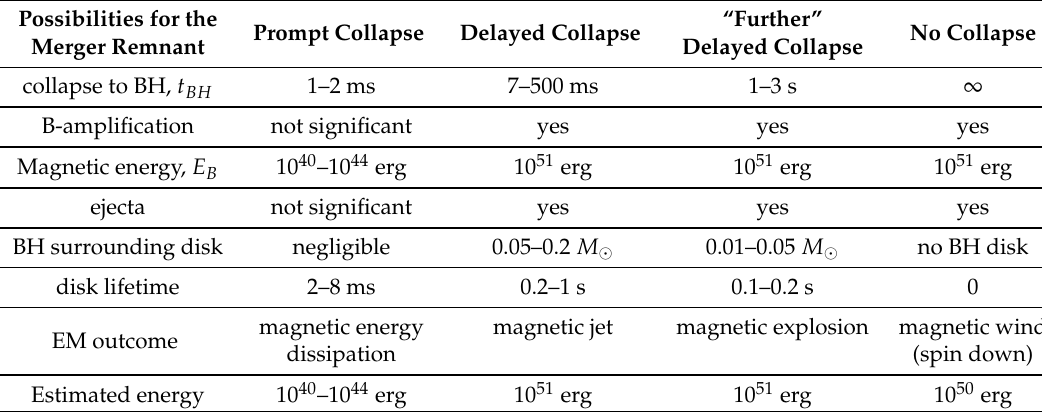
Figure 7. Snapshots of the density and poloidal velocity field for a model from [108]. The velocity vectors and their length correspond to the logarithm of the velocity in the poloidal plane. The left panel shows a region of 2000 km, whereas the right panel a narrower region of 300 km. This profile corresponds to t ∼ 1.6 s after merger. (Reprinted from [108]. c (cid:13) AAS. Reproduced with permission). Table 1. Outcome of the collapse of the merger remnant, the different columns indicate the different possible outcomes for the merger remnant. The different outcomes depend on the collapse time to a BH. Different rows, from top to bottom, are: the collapse time to a BH t BH , if magnetic field amplification occurs or not, the amount of magnetic energy E B , if there is ejected matter, the amount of mass surrounding the BH when it is formed, the lifetime of this disk around the BH, whether the EM outcome will be produced either by collapse or by the absence of collapse, and the estimated energy that is released during the collapse or the absence of